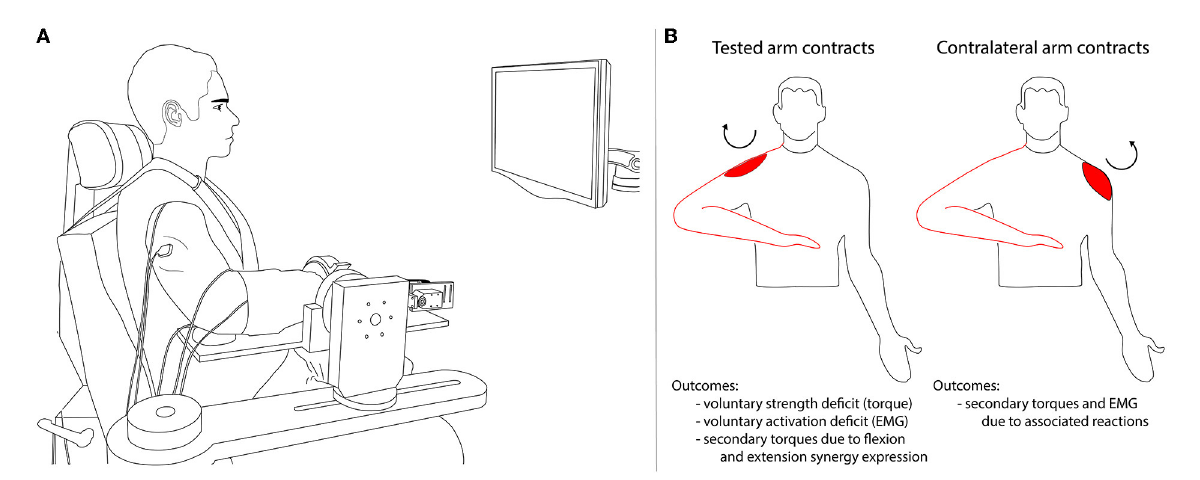
FIGURE1 Experimental setup (A) and overview of the experimental protocol and outcome variables (B) . In (A) the participant performed isometric torque generation in one direction per trial (shoulder abduction or adduction, elbow flexion or extension, wrist flexion or extension, or finger flexion or extension). Secondary torques generated at joints other than the intended (primary) torque direction were recorded along with surface EMG of shoulder, elbow, wrist, and finger muscles. In (B) the tested arm that was secured to the isometric testing setup is outlined in red. The ipsilateral contraction conditions are illustrated on the left: the experimental task was completed by the tested arm. The contralateral contraction conditions are illustrated on the right: the experimental task was completed by the arm contralateral to the tested arm. The circular arrow and red shape indicate the primary torque direction and associated agonist muscle (in this example, shoulder abduction and